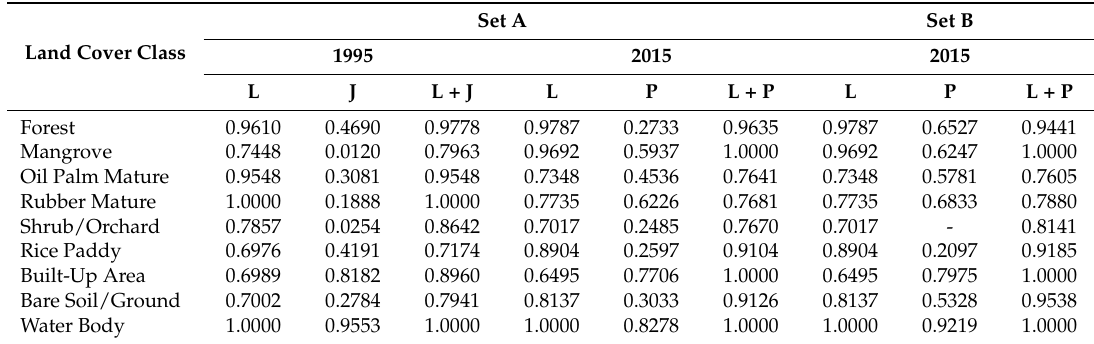
Table 7. F-scores of land cover classes from the classification results of the Landsat-only (L), SAR-only (J or P), and Landsat + SAR (L + J or L + P)